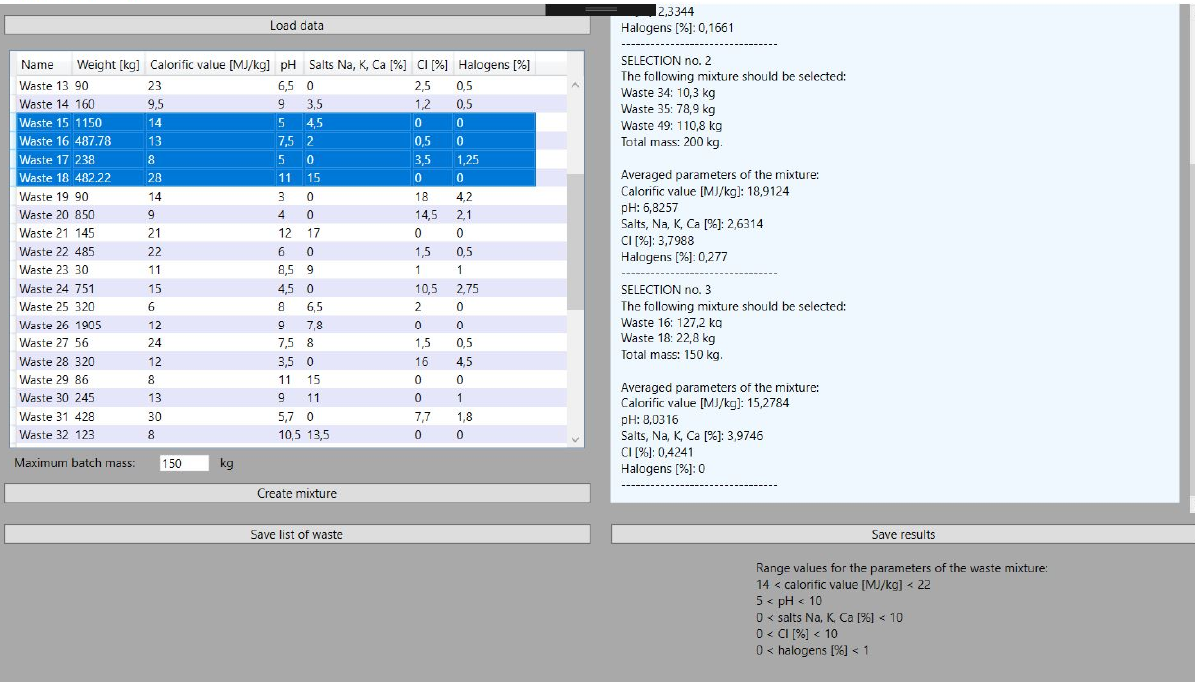
Figure 9. The change in the mass mixture.